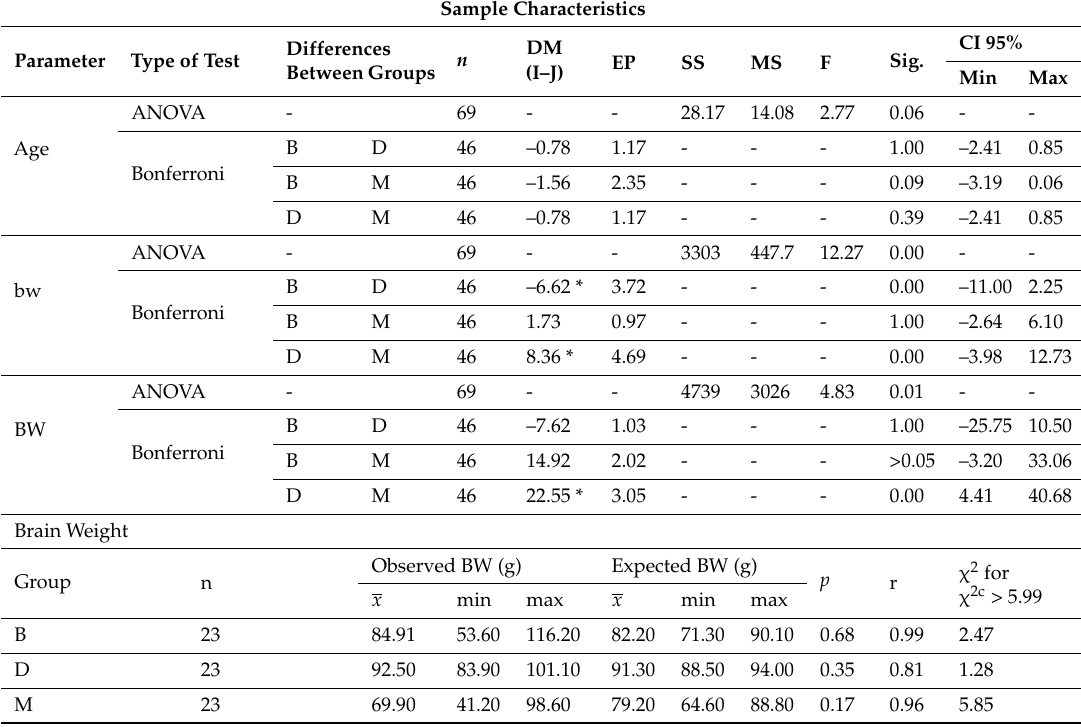
Table 2. One-way ANOVA and post hoc Bonferroni corrected tests for differences in age, living weight, brain weight, maximum width, length and height between the brachy (B), dolicho (D) and mesaticephalic (M) dogs. The comparison between groups was made with an n = 46 (23 specimens within each group). Also, the comparison between observed and expected brain weight values obtained by using the Bronson equation in brachy (B), dolicho (D) and mesaticephalic (M) dogs. The correlation coefficient (Pearson’s product moment correlation) between both values in the three considered groups. The difference was significant at p -values <